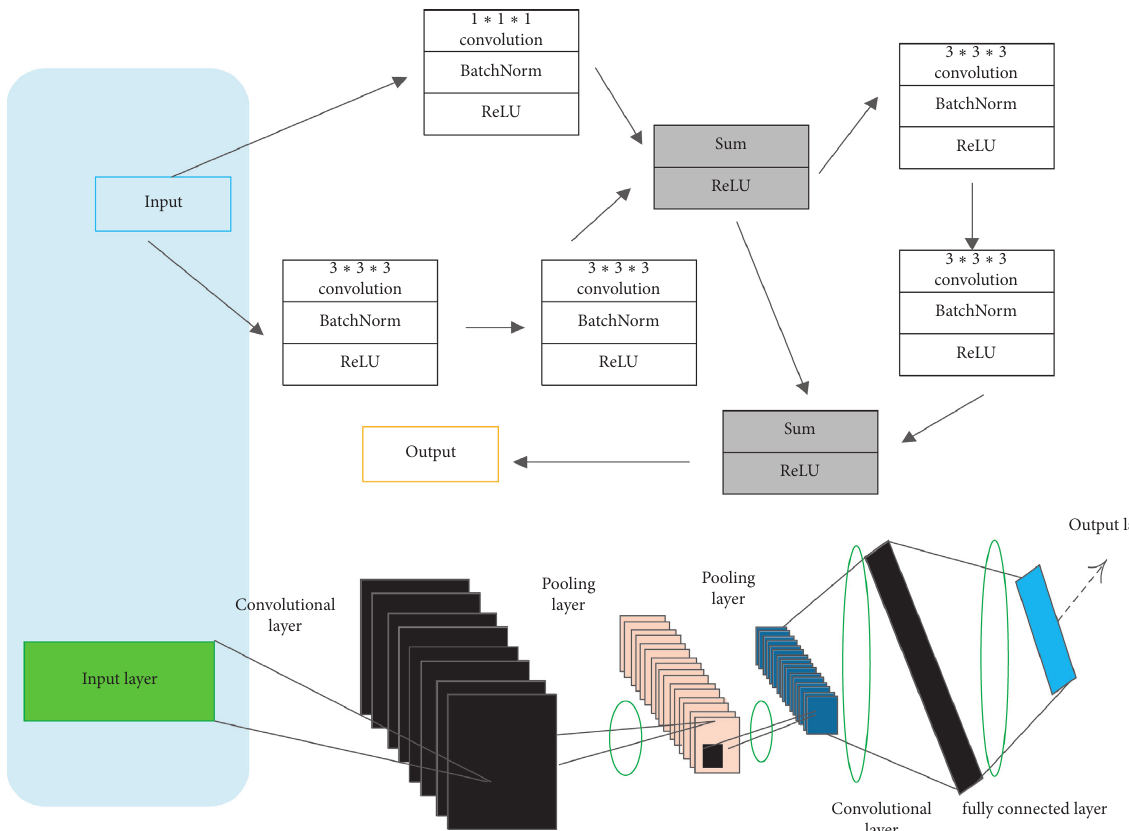
Figure 3: Time stream network channel data preprocessing.